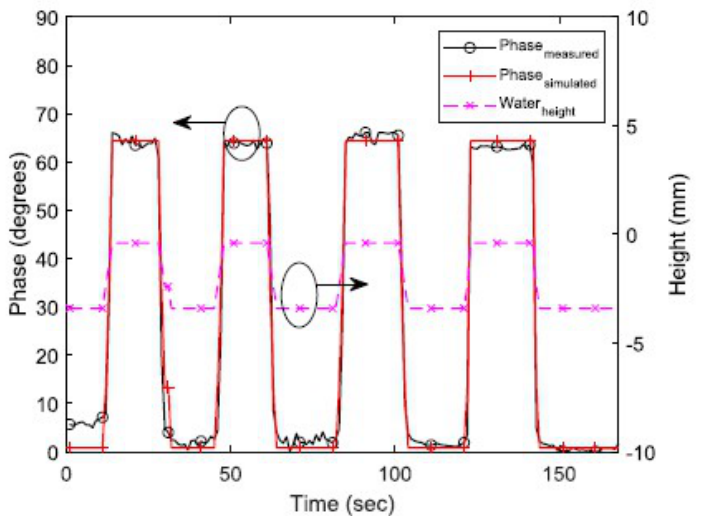
Figure 24. Results of the flood sensor showing varying phases of the backscattered signal at different water levels [39].